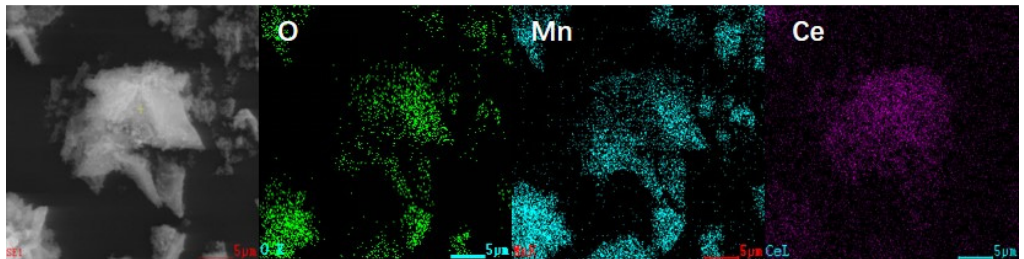
Figure 5. SEM–EDS mapping of 3% CeO 2 –MnO X .